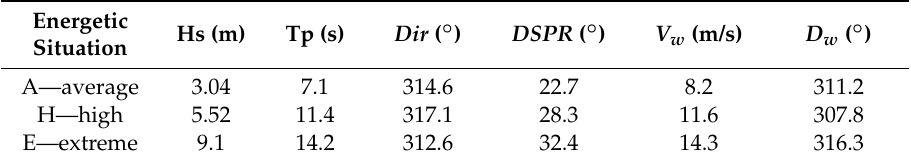
Table 3. Values of the main wave and wind parameters defined for the north western (offshore) boundary of the SWAN computational domain. A—average wave conditions, H—high wave conditions, E—extreme wave